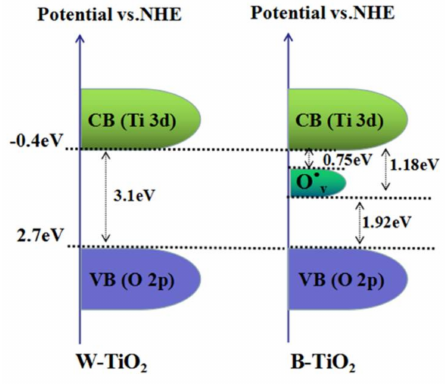
Figure 8. The band energy diagram of B-TiO 2 and W-TiO 2